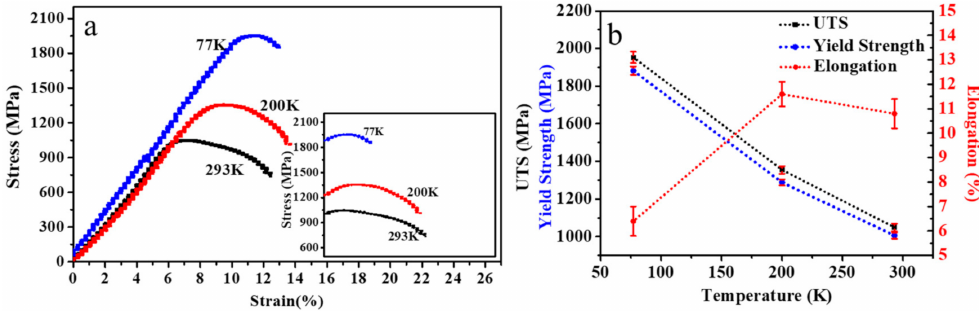
Figure 1. ( a ) Engineering stress-strain curves of EP0.58 (the insets in ( a ) is the stress-plastic strain curve), ( b ) yield strengths, ultimate tensile strengths (UTS), and elongations to fracture of EP0.58.